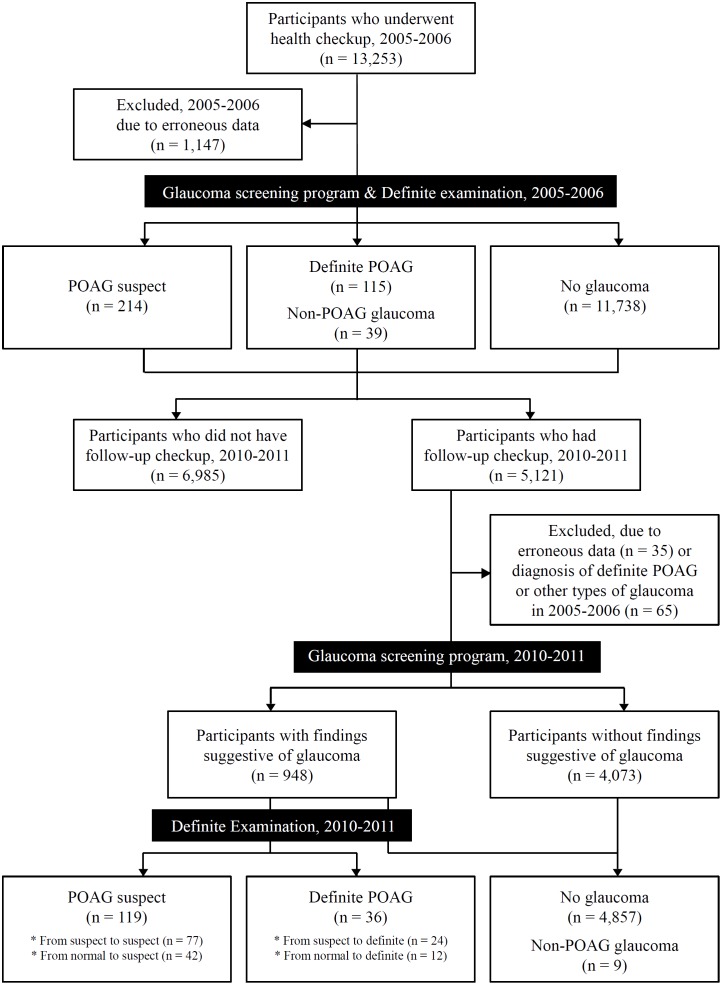
Flow diagram of participant progress in Gangnam Eye Study.